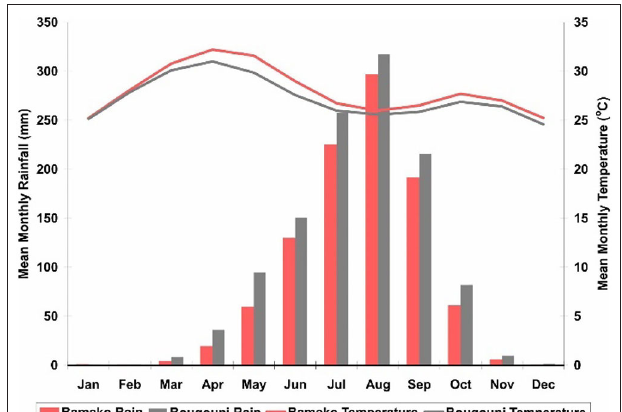
FIGURE 2 | Average monthly rainfall (bars) and mean monthly temperature (lines) for Bamako (pink) and Bougouni (gray) as the averages from two sources ( National Center for Atmospheric Research, 2009; Royal Netherlands Meteorological Institute, 2009 ). Period of record 1981–2008. Data from Henry